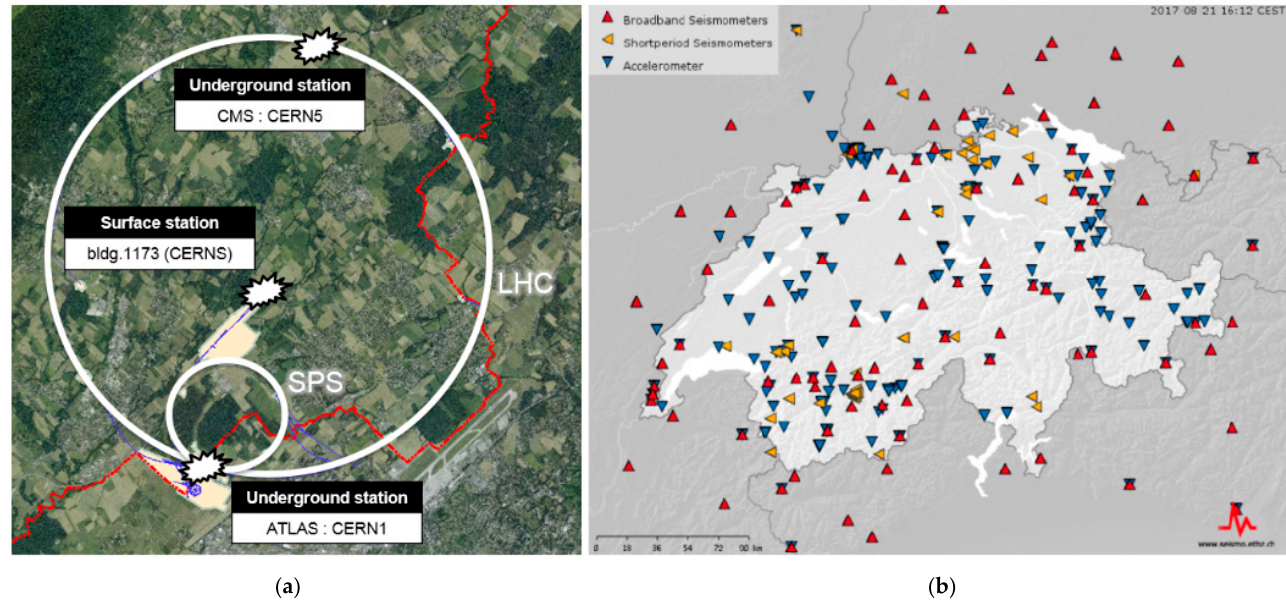
Figure 2. ( a ) CERN seismic stations locations [4]; ( b ) location of all seismic stations in Switzerland